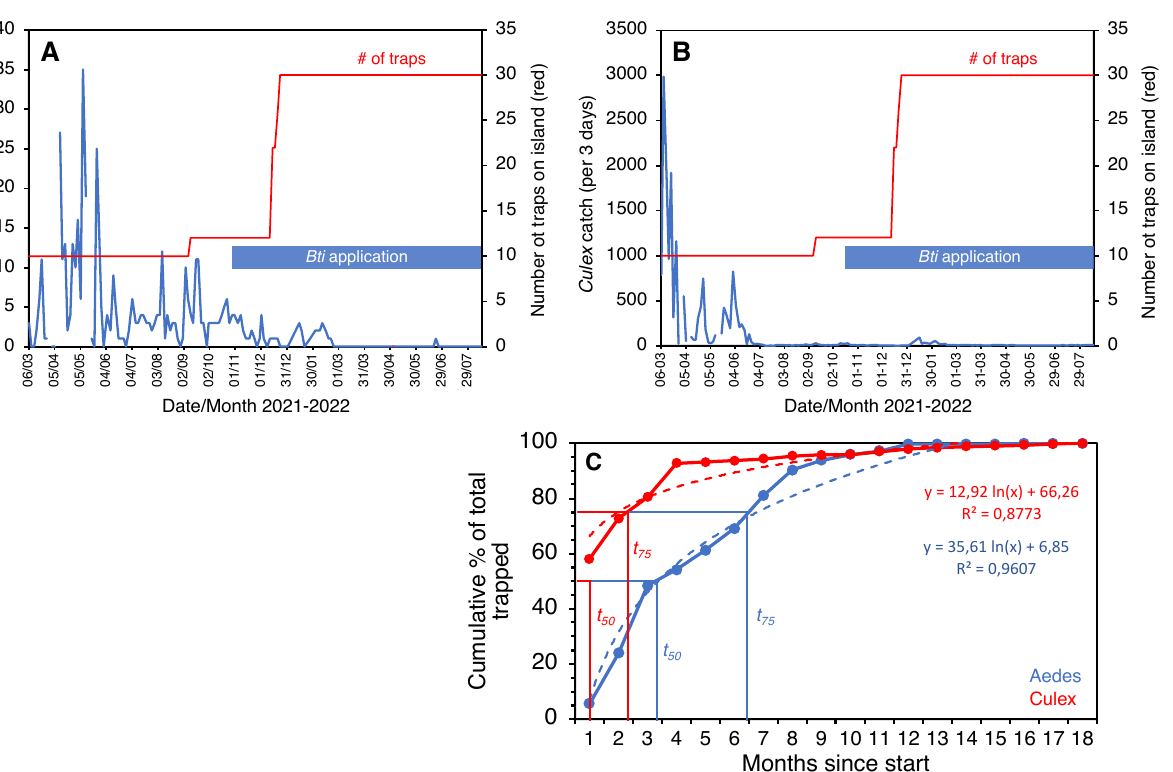
Figure 9. Three-day catches of Ae. albopictus ( A ) and Cx. quinquefasciatus ( B ) from Thahigandu Kolhu island between March 2021 and August 2022. Over time, the trap number (red line) was increased from 10 to 30, and larviciding with Bti (blue bar) was conducted weekly from 28 October 2021 onwards. Elimination of Aedes mosquitoes was accomplished on 20 February 2022. One mosquito was caught at the end of June but identification was inconclusive. Gaps in the blue line graphs indicate absence of data (due to lack of electricity on the island). Graph ( C ) shows the cumulative percentage of mosquitoes removed from the island over the entire 18-month period, showing the time needed to trap 50% (t 50 ) or 75% (t 75 ) of all mosquitoes collected for both species. Results from the trials with neem oil and sea water as potential larvicides are shown in Figure 10. For neem oil, complete prevention of adult emergence was observed at 800